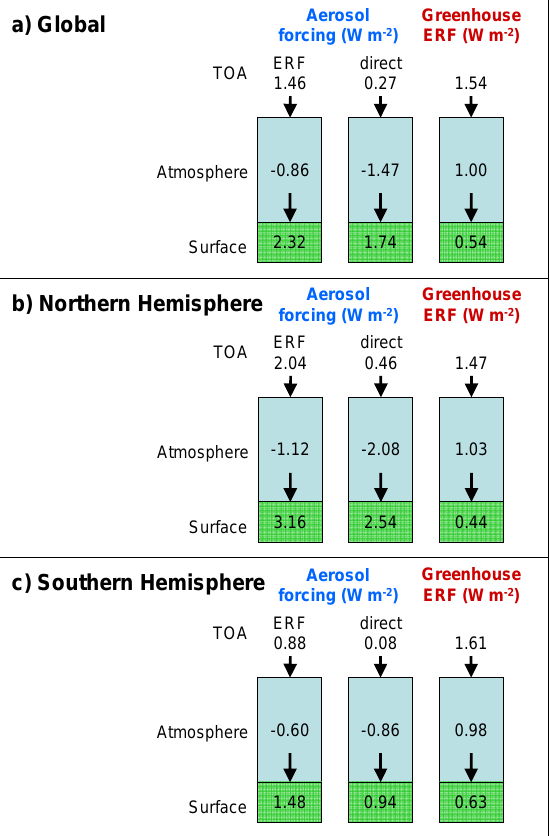
surface for 2100 minus 2005 in RCP4.5, calculated from fixed-SST simulations: (a) global-mean, (b) Northern Hemisphere, (c) South- ern Hemisphere. The first two columns show the total aerosol ERF and the (instantaneous) direct radiative forcing. The third column shows the ERF for long-lived